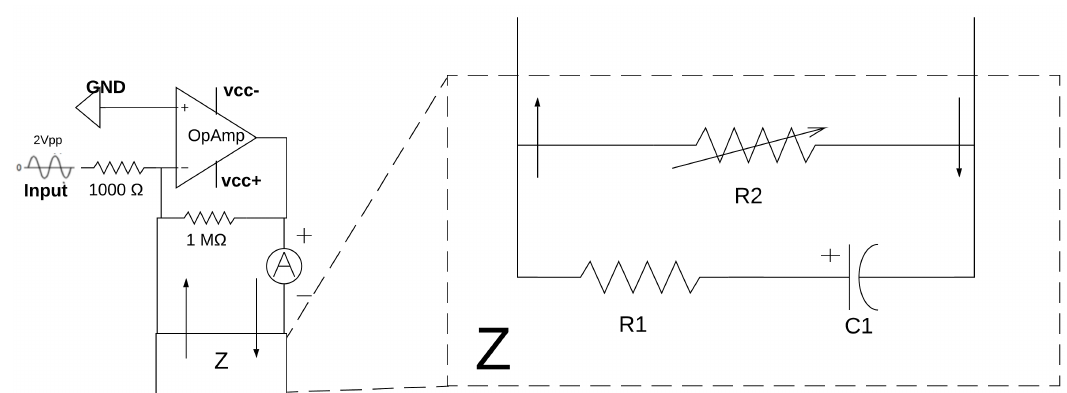
Figure 4. Impedance set-up for the voltage-controlled current source (VCCS) testing, with Z =